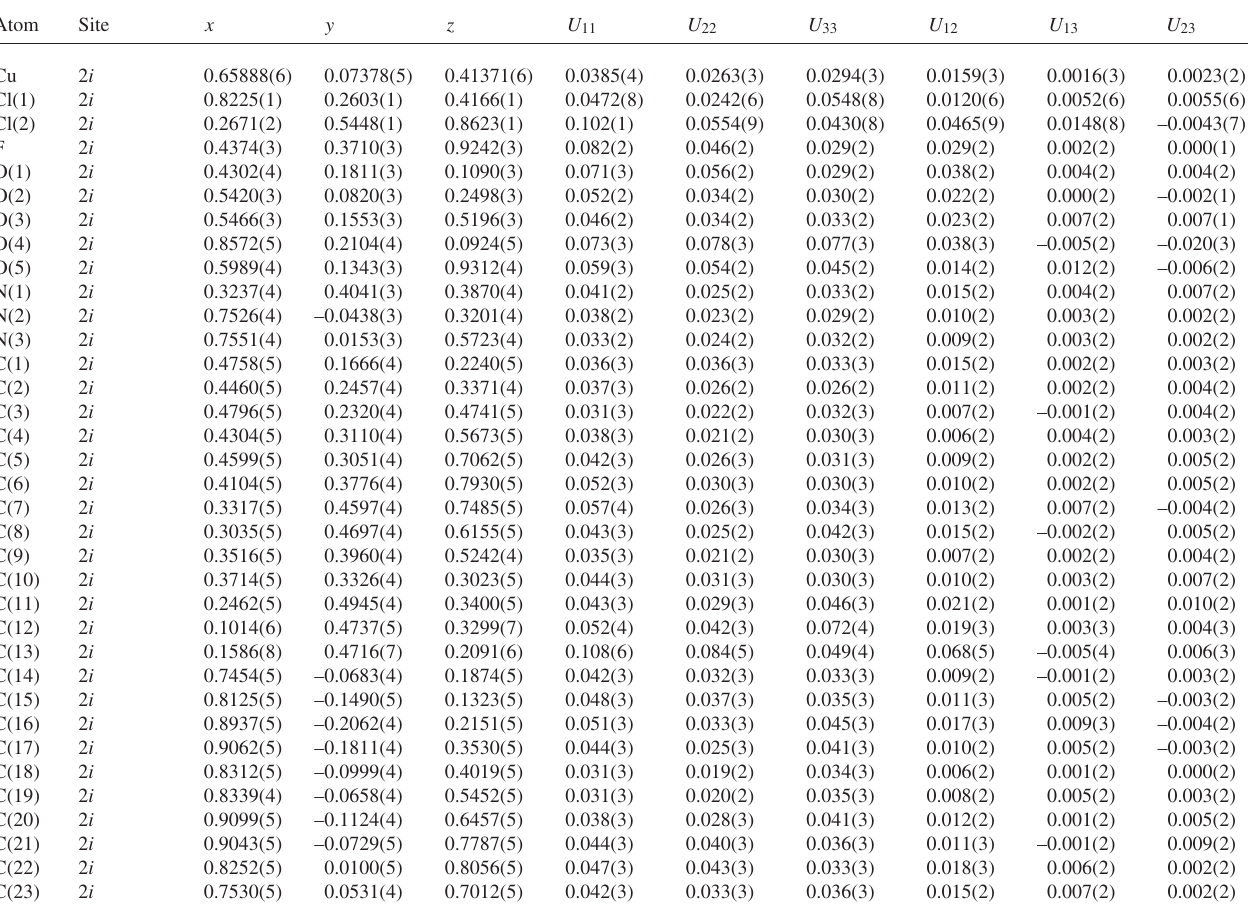
Table 3. Atomic coordinates and displacement parameters (in Å 2 ) .